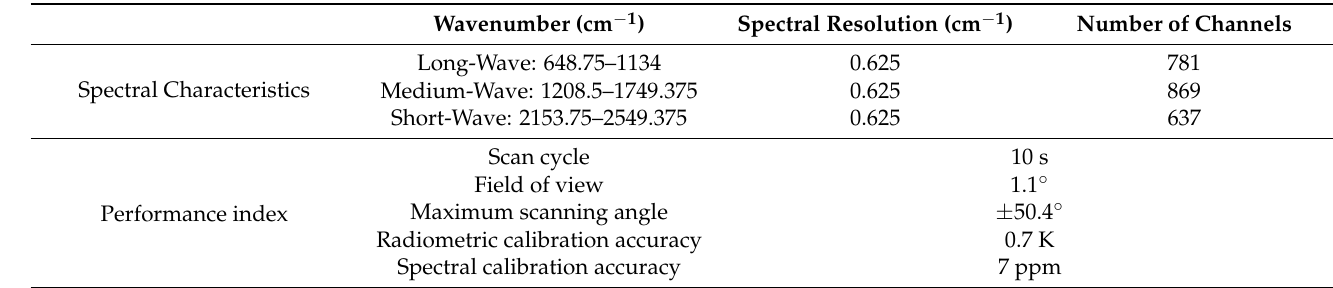
Table 1. FY-3D/HIRAS spectral characteristics and performance indicators